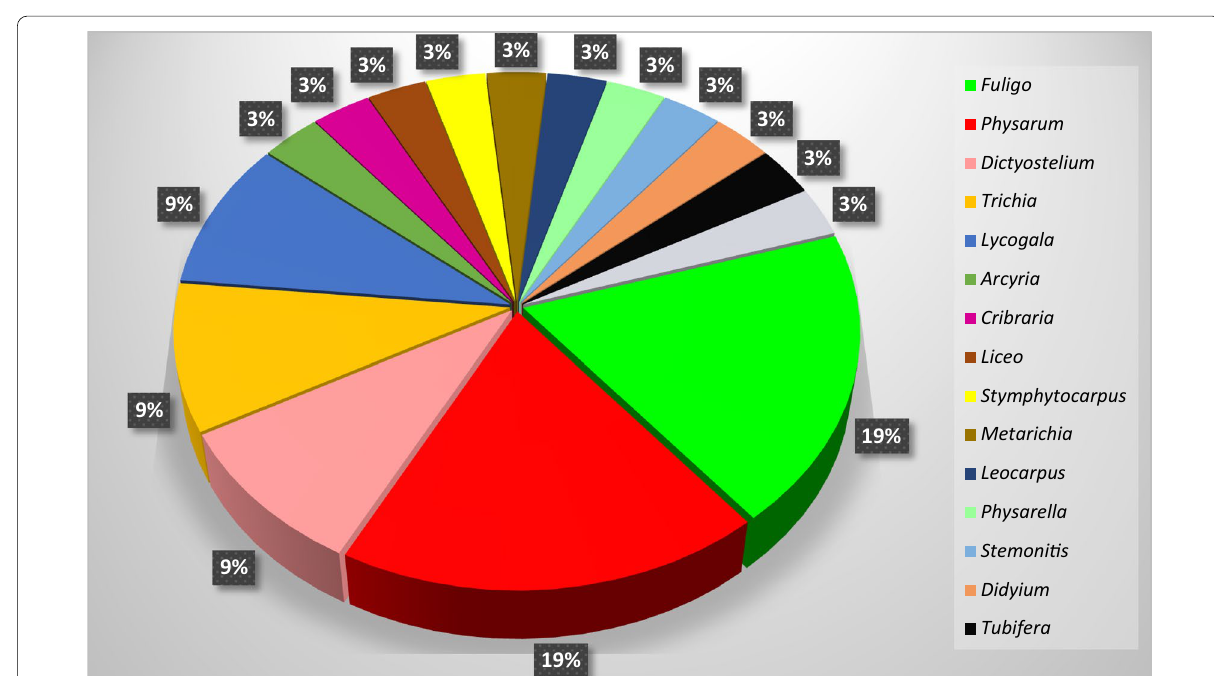
Fig. 10 The pattern of distribution of the reported slime molds producing antimicrobial